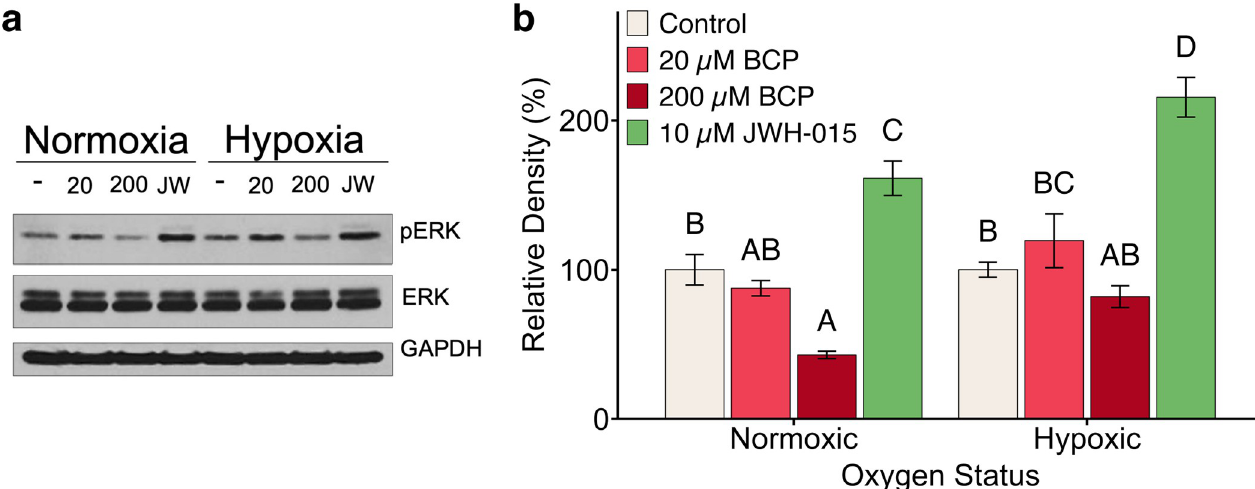
Fig 8. pERK expression is reduced in the presence of 200 μ M BCP. Panel a. UFH-001 cells were exposed to normoxic or hypoxic conditions for 16h in the presence or absence of BCP. A second set of UFH-001 cells was exposed to normoxic or hypoxic conditions for 15 ½ h after which JWH-015 (10 μ M) was added for the final 30 min (total of 16h of normoxia and hypoxia). Cells were washed with PBS and lysed with RIPA buffer containing protease inhibitors. Equal protein concentrations from the soluble phase were used to load SDS-PAGE gels which were then transferred to nitrocellulose for analysis of ERK, pERK and GAPDH (loading control). Panel b. These data represent the relative densities of the bands in Panel a where the bars represent the means ± S.E.M of 3–5 replicates. Data were analyzed by two-way ANOVA.